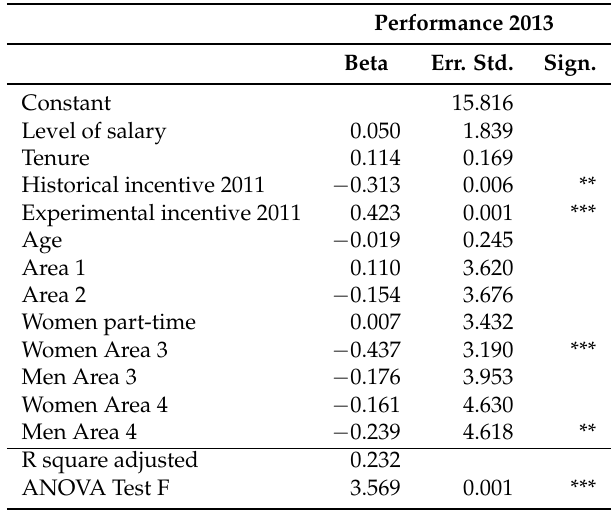
Table A3. Results of linear regressions described in Equation (6) considering some interactive variables. ** Significant at the 5%. *** Significant at the